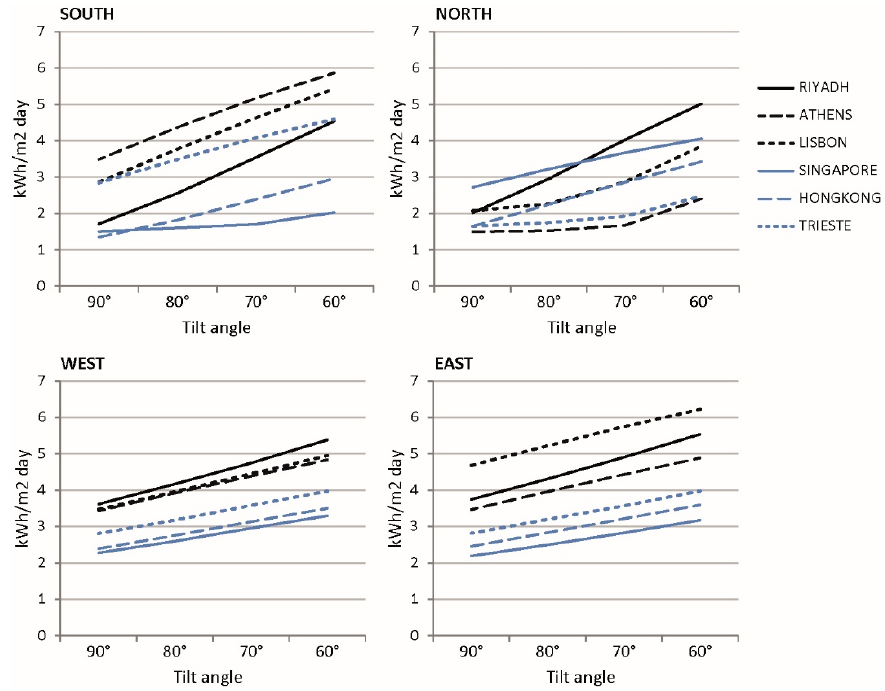
Figure 4. Relation between solar irradiance and the tilt of the receiving surface, for every orientation and location.